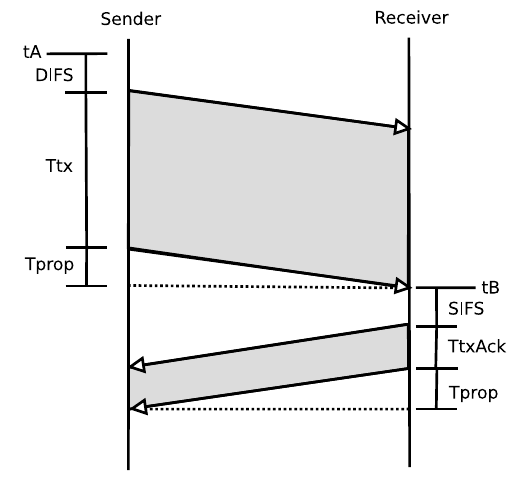
Figure 5. Successful packet transmission in 802.11 Fig. 5: Successful packet transmission in 802 . 11 networks